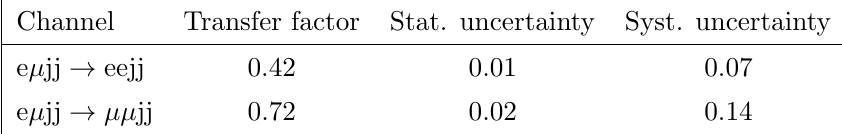
Table 1 . Transfer factors applied to the number of events in the (cid:13)avor control region to estimate the number of tt events in the eejj and (cid:22)(cid:22) jj signal regions. number of events in the signal region is then given